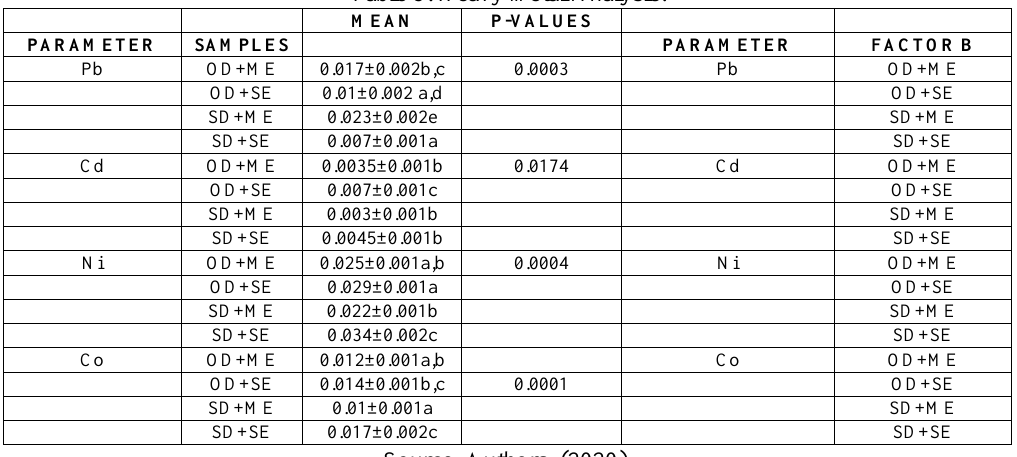
Table 3: Heavy metal Analysis.